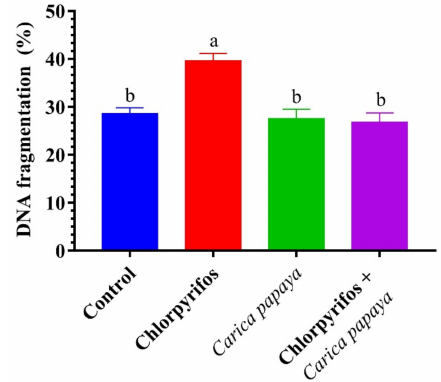
Figure 4. DNA fragmentation (%) of female African catfish, Clarias gariepinus , exposed to chlorpyrifos (8.75 µ g/L.) and co-administrated with papaya, Carica papaya aqueous extract (250 mg/kg body weight) for 6 weeks. The column bearing with different letters are significantly different ( p <